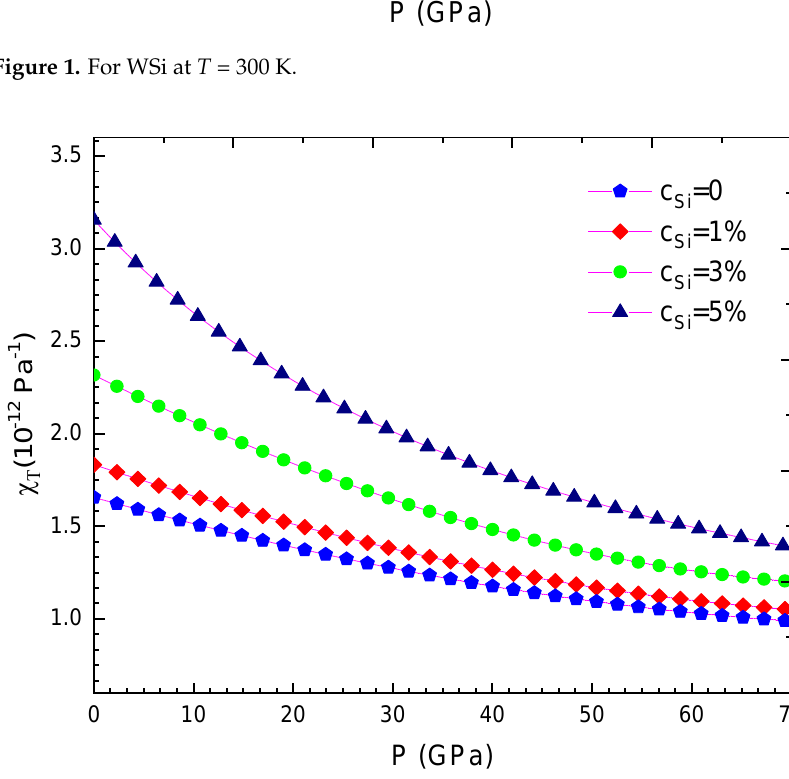
Figure 2. For WSi at T = 300 K. Table 4. Si concentration and pressure dependence of thermal expansion coefficient